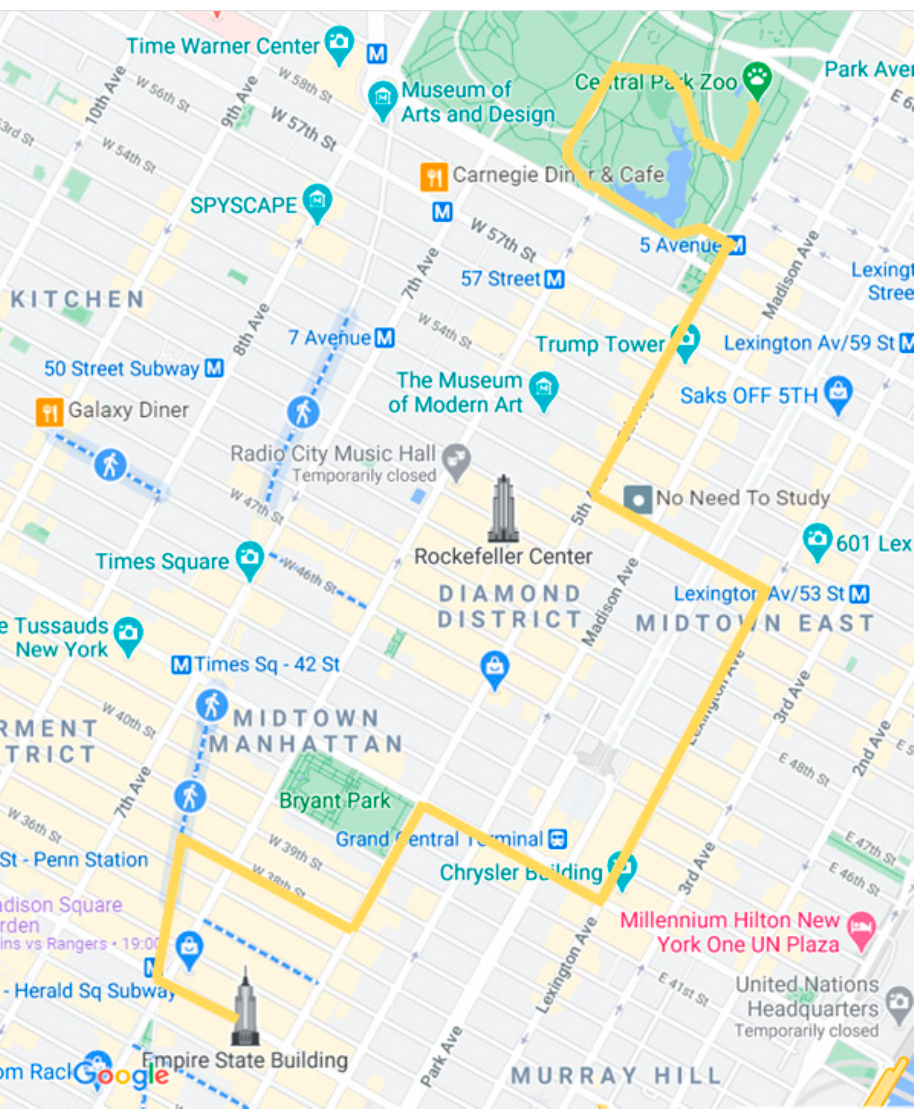
Figure 11. Tourism walking route for case study 2 traversing the main landmark and attraction locations in the area (background: Google Maps). locations in the area (background: Google